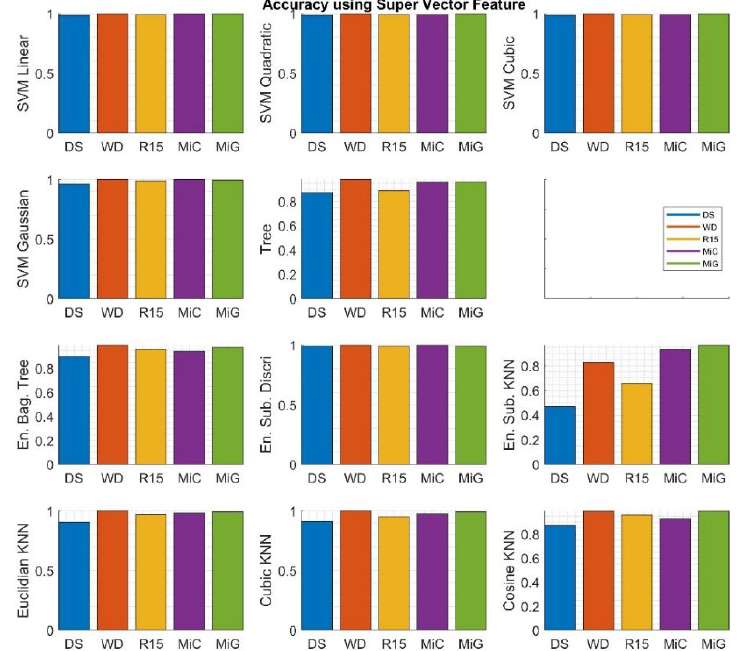
Figure 6. Boxplots calculated over the gathered classification results using the Super Vector feature set. Each column in the figures corresponds to a different sensor.